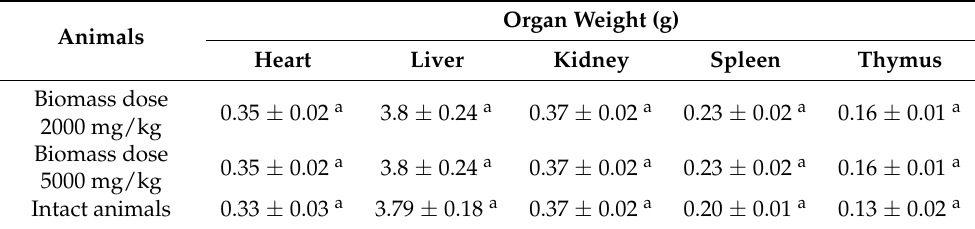
Table 3. Relative weight of laboratory rats’ organs two weeks following the administration of D. deltoidea cell